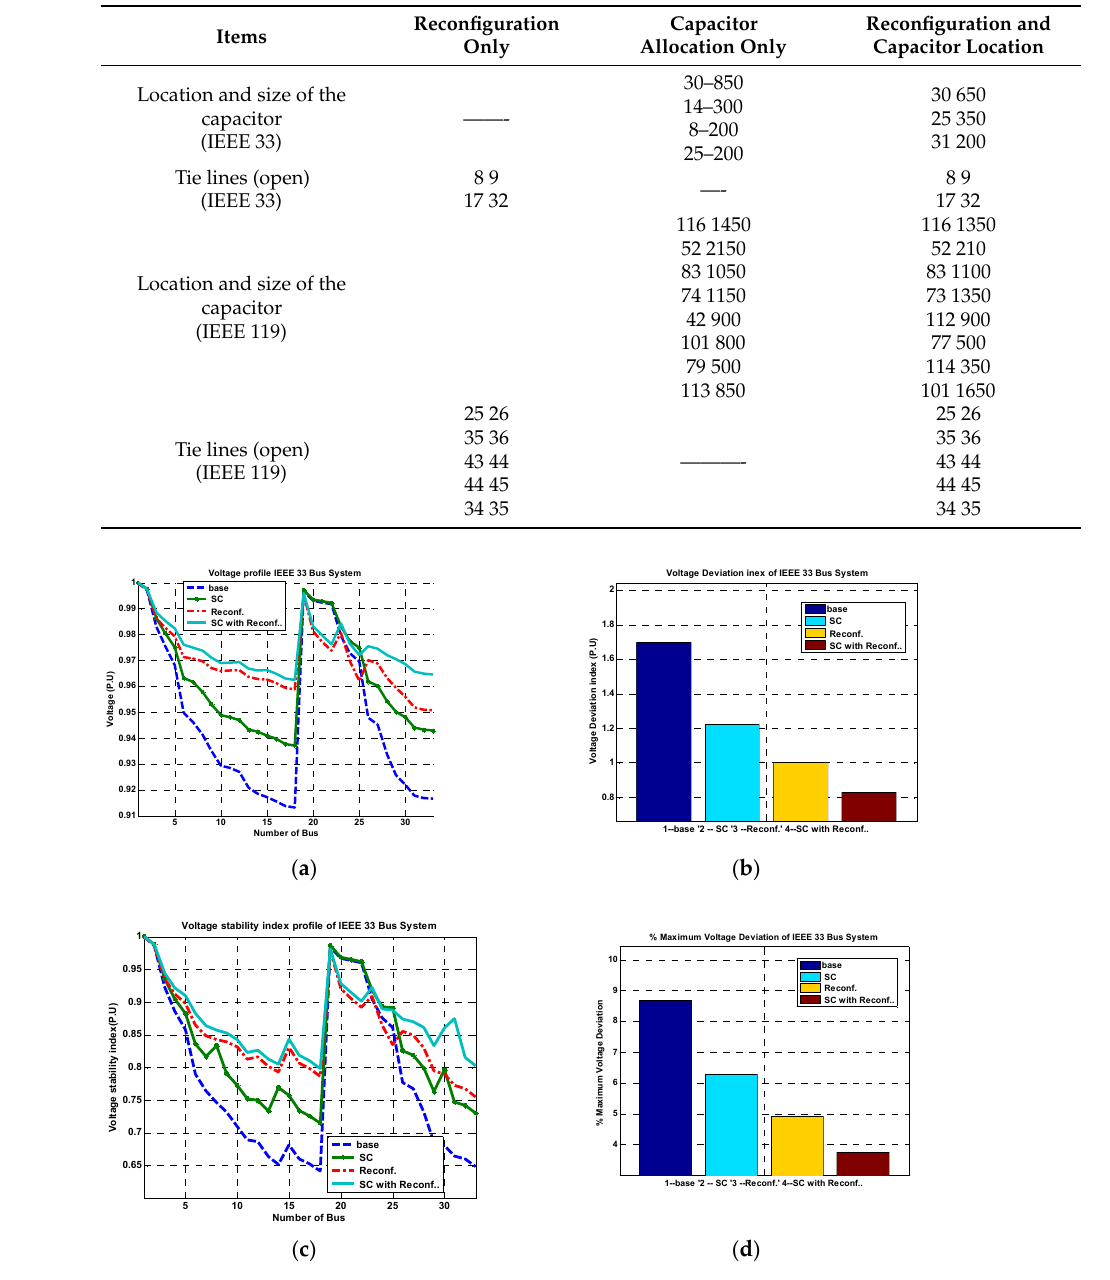
Table 3. The outputs of the proposed method.